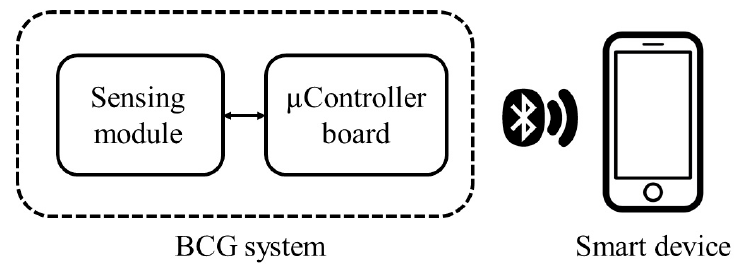
Figure 1. Block diagram of the system.